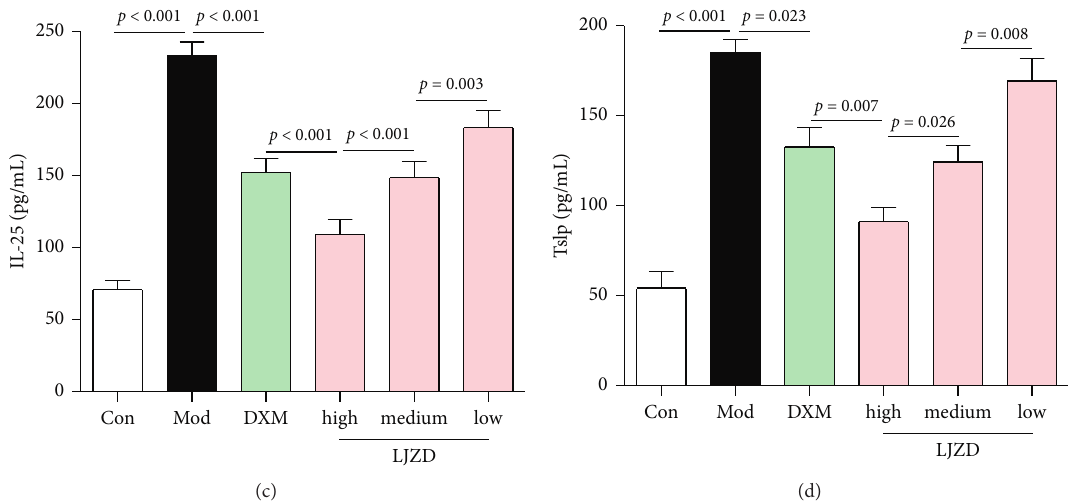
Figure 5: LJZD decreased the protein expression levels of IL-17a (a), IL-23 (b), IL-25 (c), and Tslp (d) in lung tissues of asthmatic mice by ELISA. Each value represented the mean ± SD from at least three independent